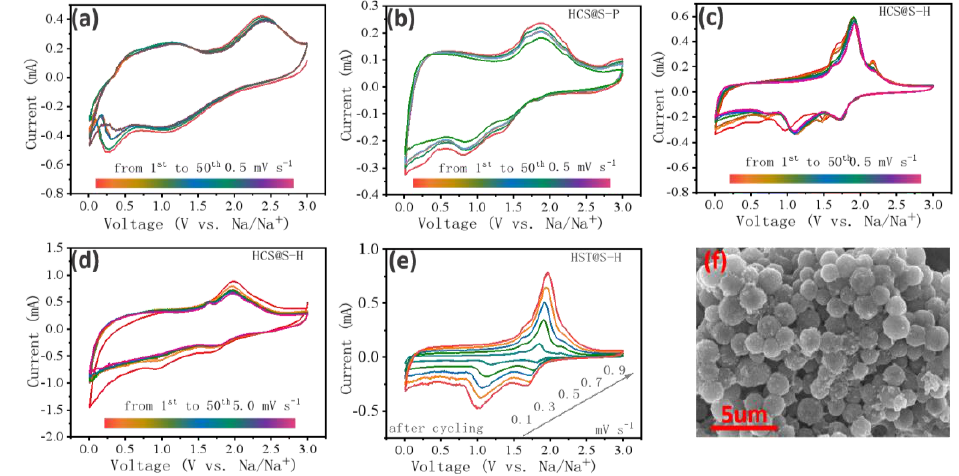
Figure 6. The long-term cycles from 1st to 50th 0.5 mV s -1 for CF@S-H ( a ), HCS@S-P ( b ) and HCS@S-H ( c ), at 5.0 mV s -1 for HCS@S-H ( d ), CV curves after cycling ( e ) and the morphology after cycling for HCS@S-H, The Mapping after 20 cycling loops of HCS@S-H( f ).